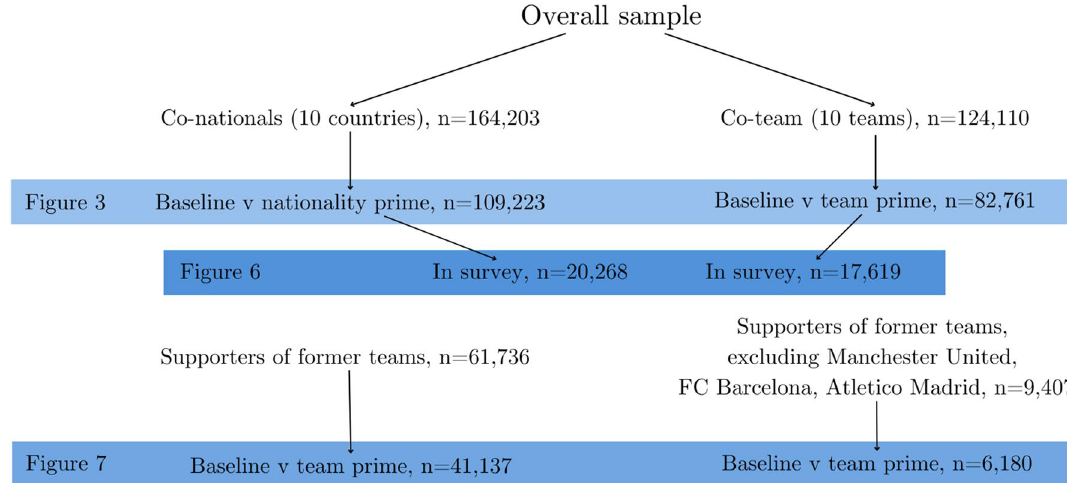
Figure 2. Samples for each analysis.